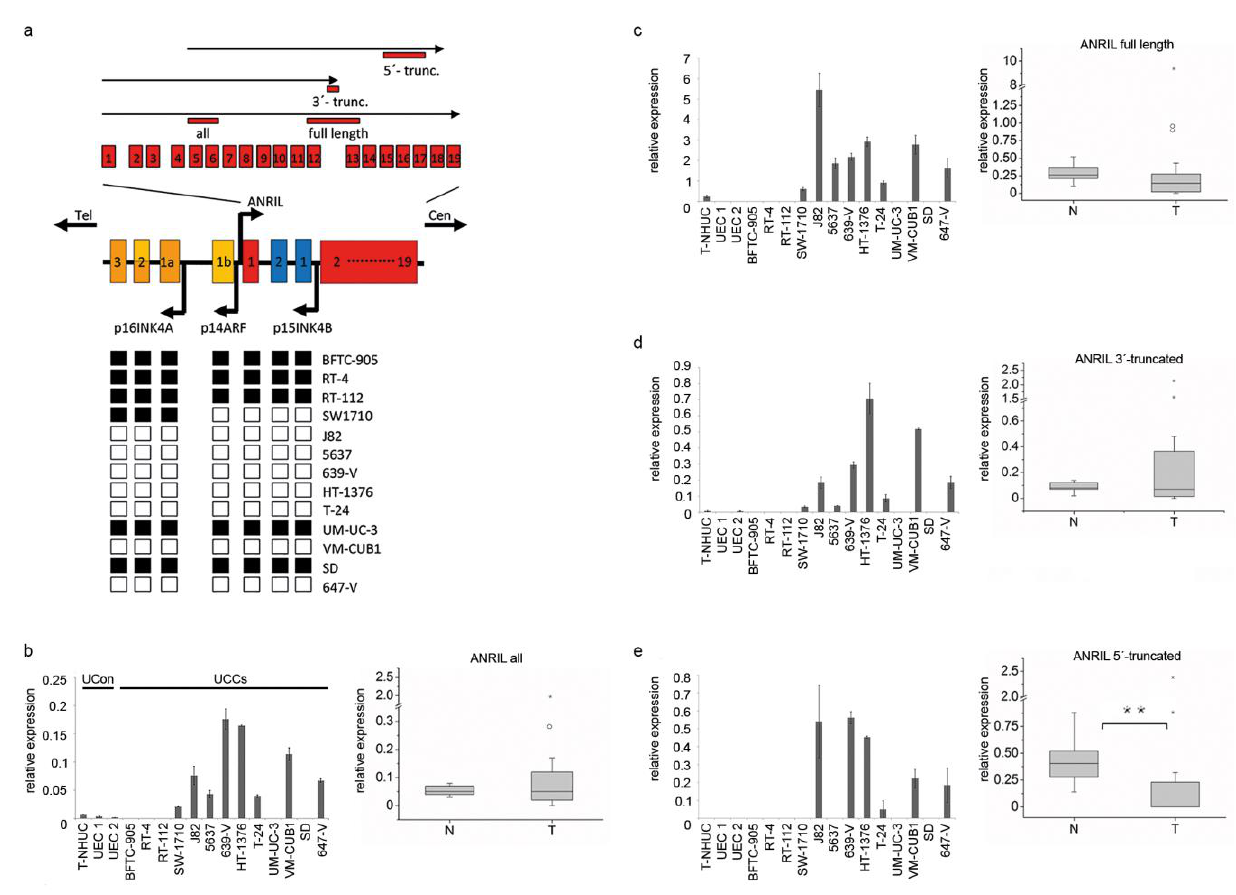
Figure 1. ( a ) Illustration of the INK4/ARF locus on chromosome 9p21 encoding for the three tumor suppressors (TS) p14 ARF , p15INK4B, p16 INK4A and for the lncRNA ANRIL. ANRIL and p14 share a bidirectional promoter. The full length ANRIL transcript contains 19 exons. Black arrows on top represent different groups of truncated variants and the localization of primer assays is given by red bars. Black and white boxes at the bottom represent the exons of the three TS. Black boxes denote deletions as determined previously by Florl et al. [4], white boxes display retentions. ( b ) ANRIL expression across all kind of isoforms was determined in UC cell lines (left graph, bar chart) and tissues (right graph, boxplot representation) with the “all” assay by quantitative RT-PCR. Expression was normalized to the TBP reference gene. The cell lines comprised 13 UC cell lines (UCCs) and three normal controls (UCon), one immortalized normal cell line (TERT-NHUC) and two different primary cultures of normal uroepithelial cells (UEC). The tissue sample set 1 comprises 19 UC tissues (T) and 10 normal bladder tissues (N). In an analogous fashion, expression of full length variants ( c ), a group of 3’-truncated ( d ) and a group of 5’- truncated isoforms ( e ) was determined in the cell lines and tissues. ( ** p ≤